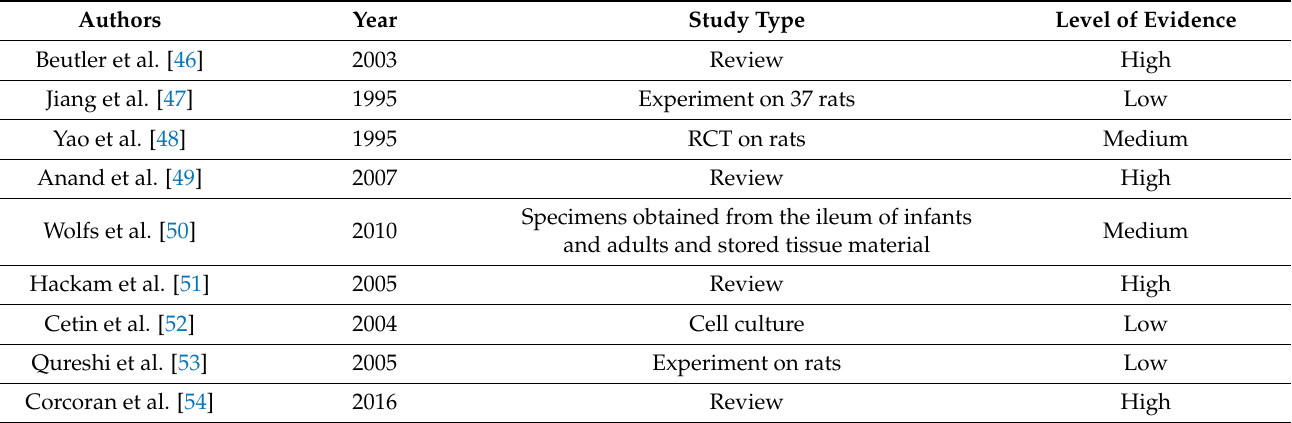
Table A4. Bacterial lipopolysaccharides (LPS/Endotoxins) and their role in the inflammatory pathway of